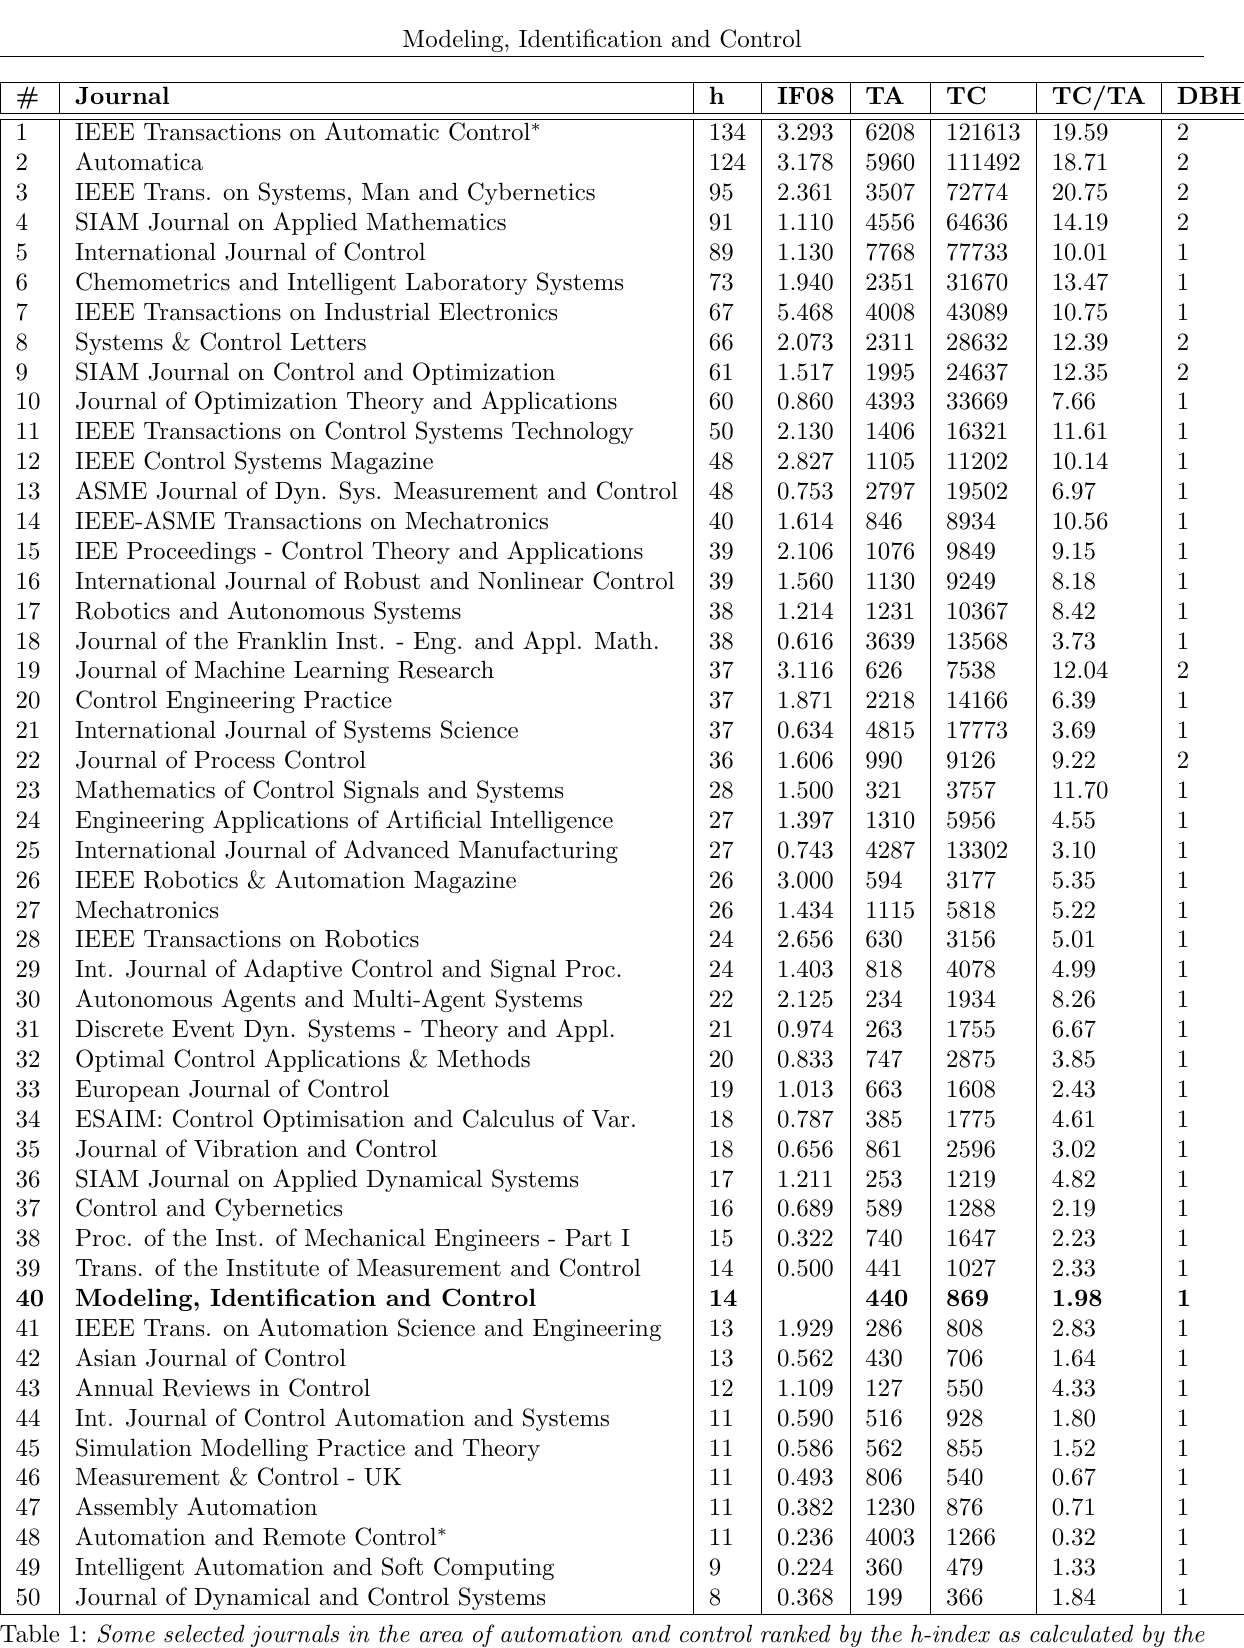
Table 1: Some selected journals in the area of automation and control ranked by the h-index as calculated by the ISI Web of Science. IF08 stands for Impact Factor 2008 , TA is the total number of articles and TC is the total number of citations for each journal. Both TA and TC were recorded on the date 15.11.2009. DBH signifies the publication level in the Norwegian DBH database. ∗ Publication data for this journal only available from the year